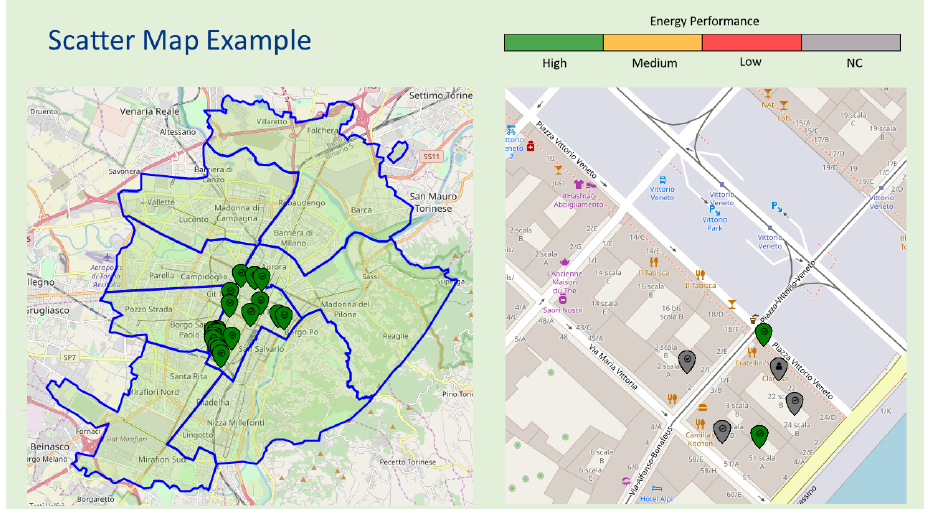
Figure 14. Example of scatter maps at: city level ( left ); and district level ( right ).